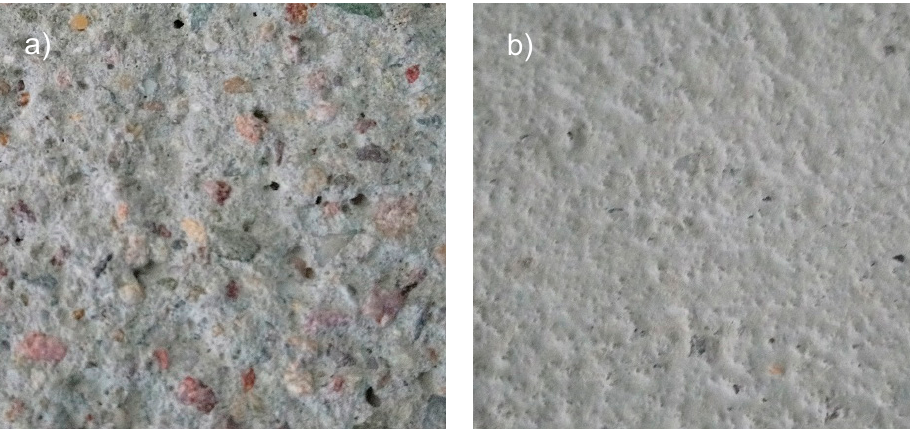
Figure 8. The exemplary view of the concrete substrate surface after shot-blasting (a) and patch grabbing (b).